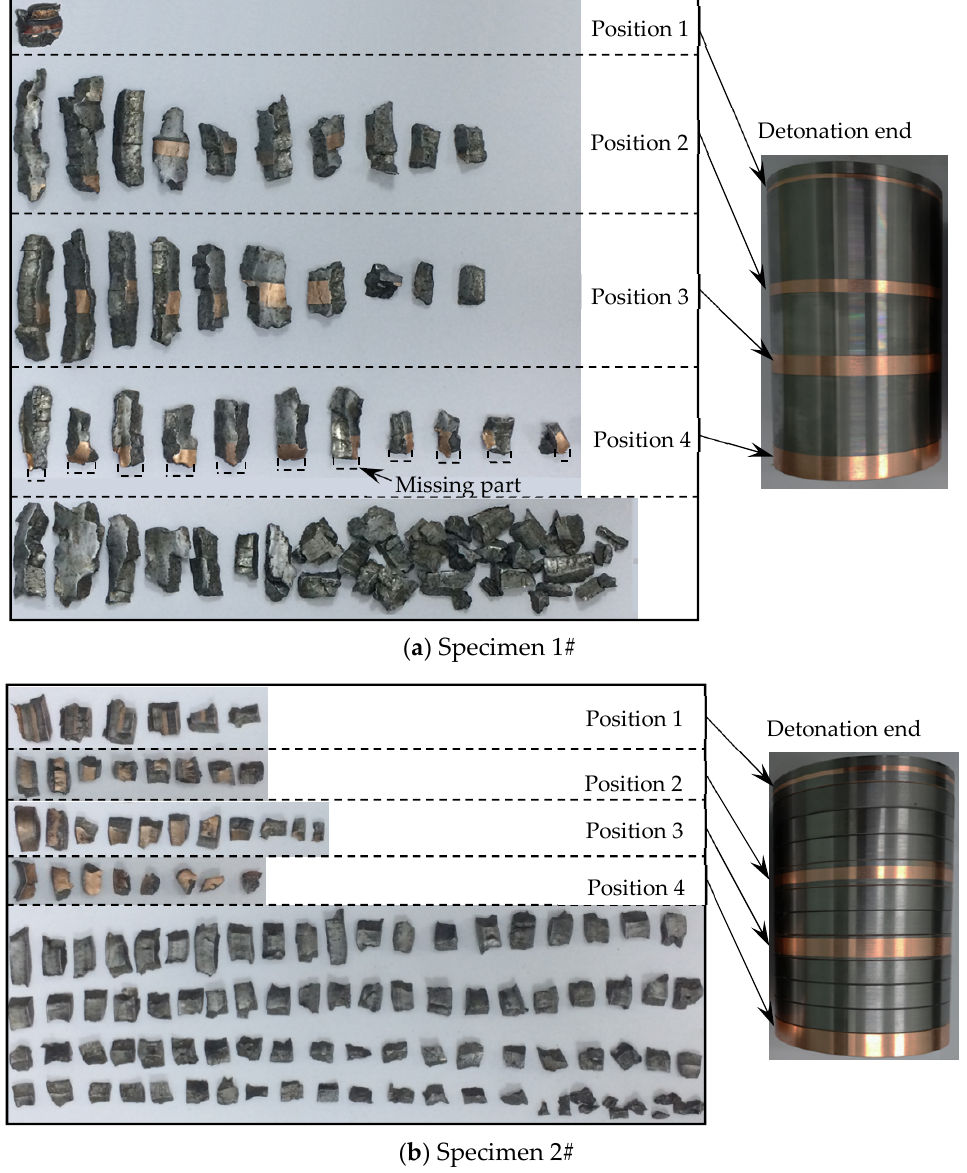
Figure 4. Recovered fragments and their original positions: ( a ) Recovered fragments and their original positions for Specimen 1#; ( b ) Recovered fragments and their original positions for Specimen 2#.